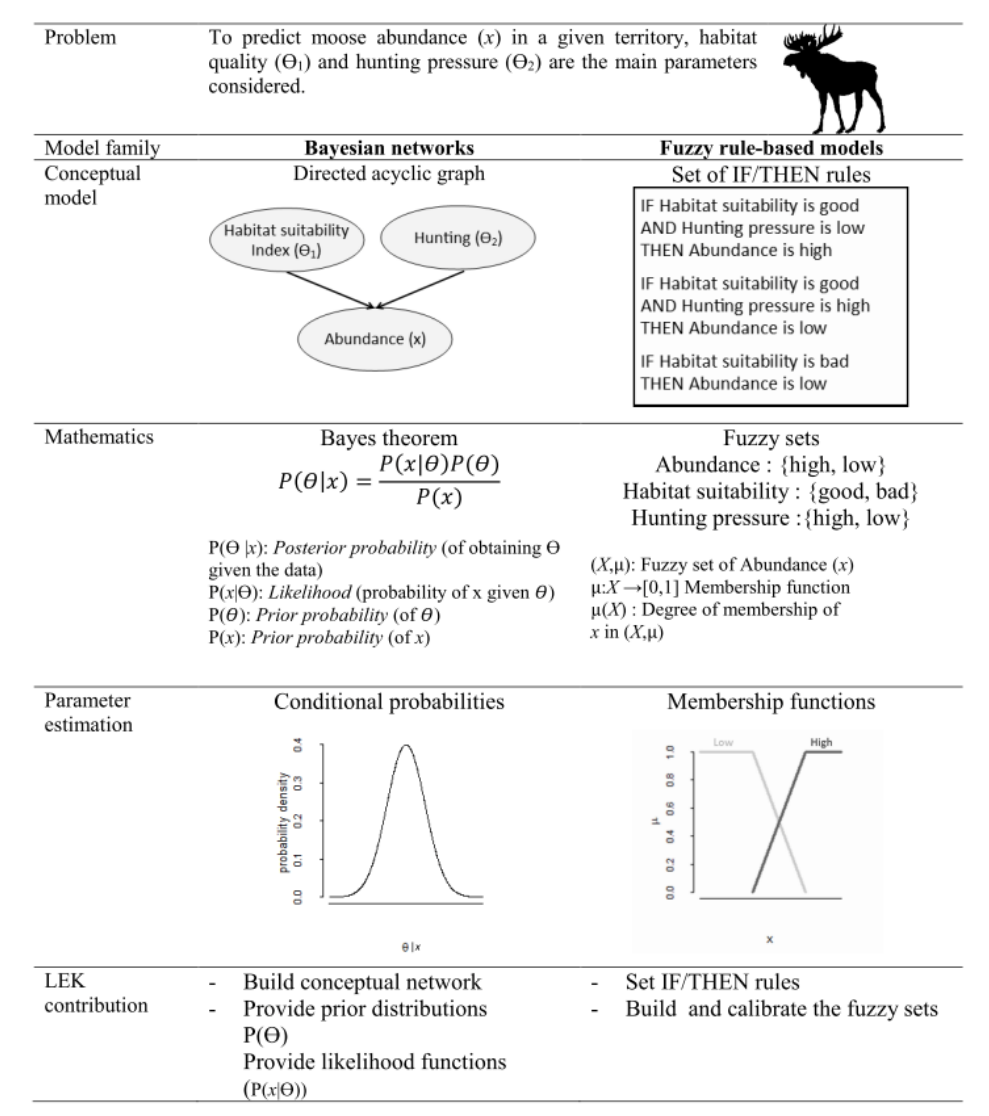
Fig. 4 . Fictive example of a moose ( Alces americanus ) population ecology study as seen through the lens of Bayesian networks and fuzzy rule-based models